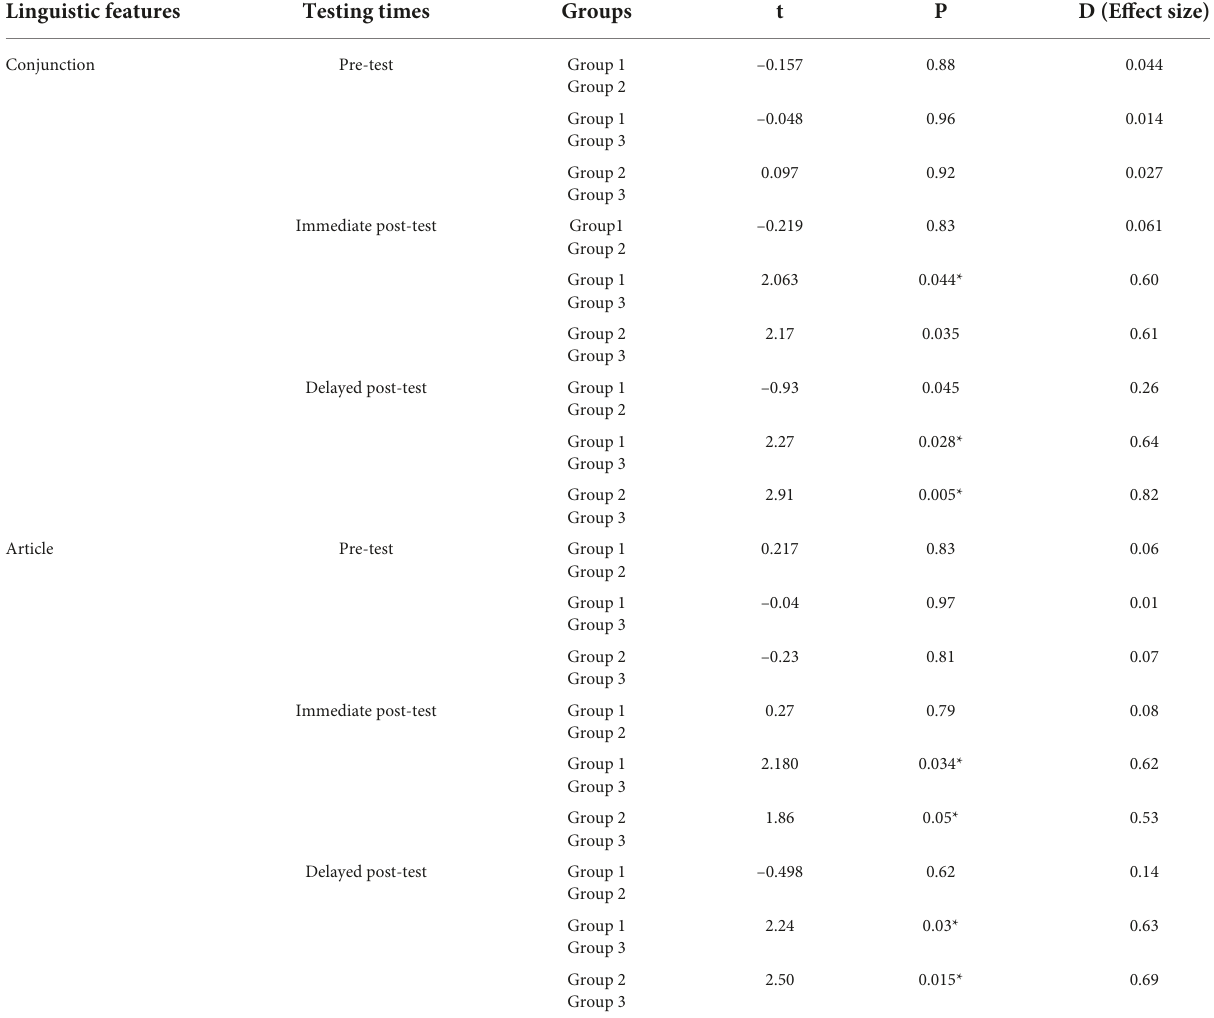
TABLE 2 Inferential statistics: three feedback types at pre- and